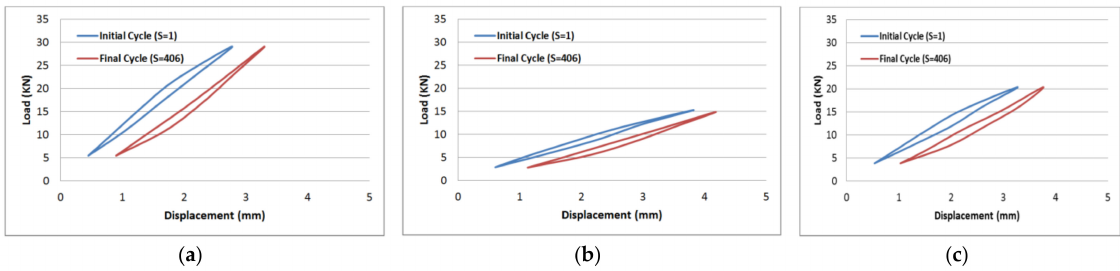
Figure 6. Load-displacement performance at 75% of the maximum load for fibre volume fraction ( a ) 50% glass fibre-reinforced polyester, ( b ) 35% glass fibre-reinforced polyester, and ( c ) 20% glass fibre-reinforced